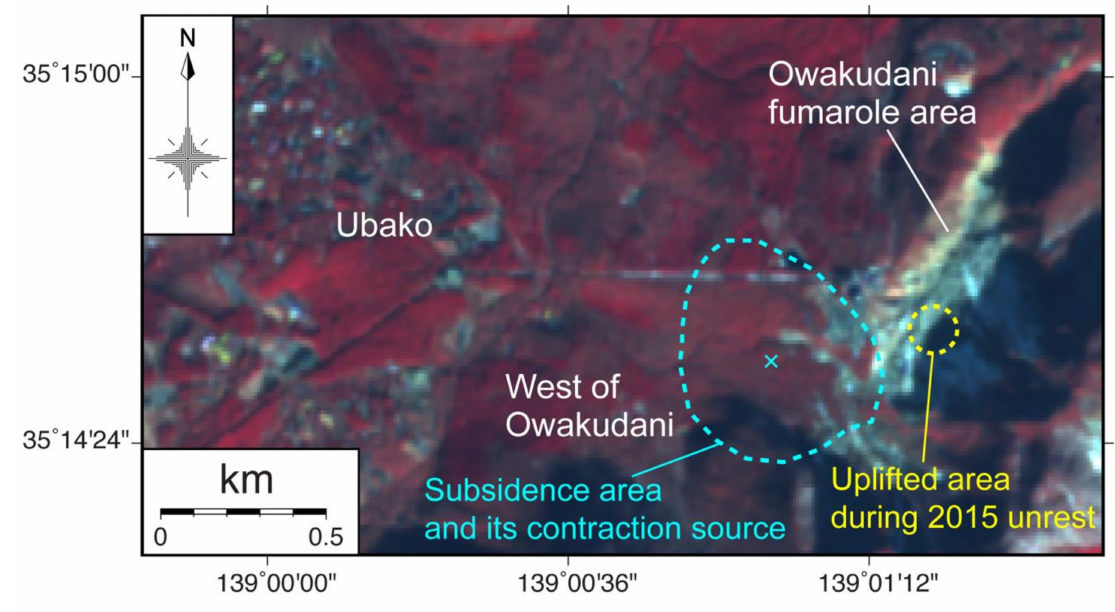
Figure 14. False-color image around the Owakudani fumarole area captured by ALOS / AVNIR-2 on 31 January 2007. The red color in the image indicates areas of vegetation, and in the Owakudani fumarole area, there is no vegetation due to geothermal and fumarolic